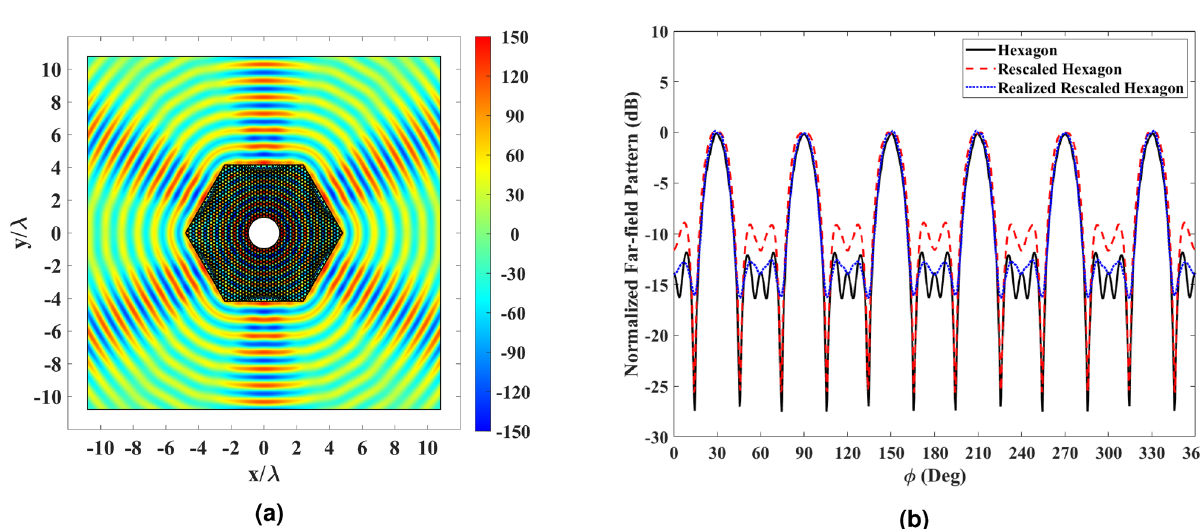
Figure 10. Simulation results for the rescaled refractive index of Fig. 5b. ( a ) Real part of the electric field for the cylindrical wire excited by an electric current. ( b ) Ray tracing results for 102 equally-spaced rays launched from the physical space’s inner rim. The color expression indicates the optical path length.